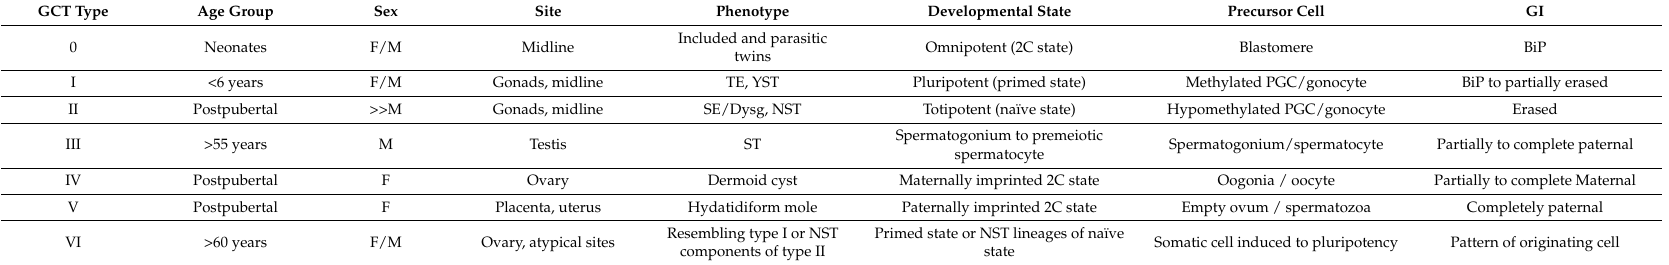
Table 3. Proposed classification of testicular germ cell tumors, according to their developmental state (adapted from